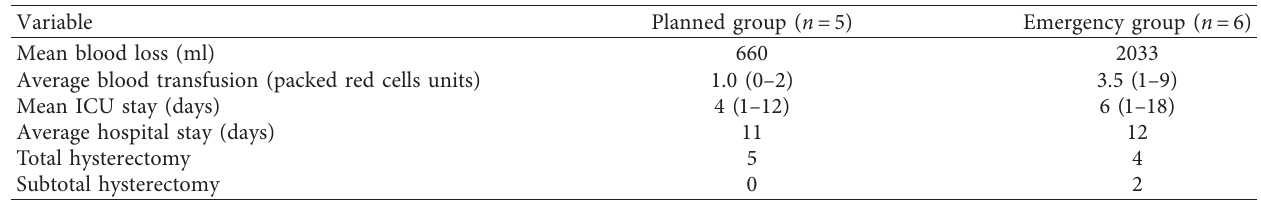
Table 2: The maternal characteristics compared in the two groups (planned/emergency peripartum hysterectomy).